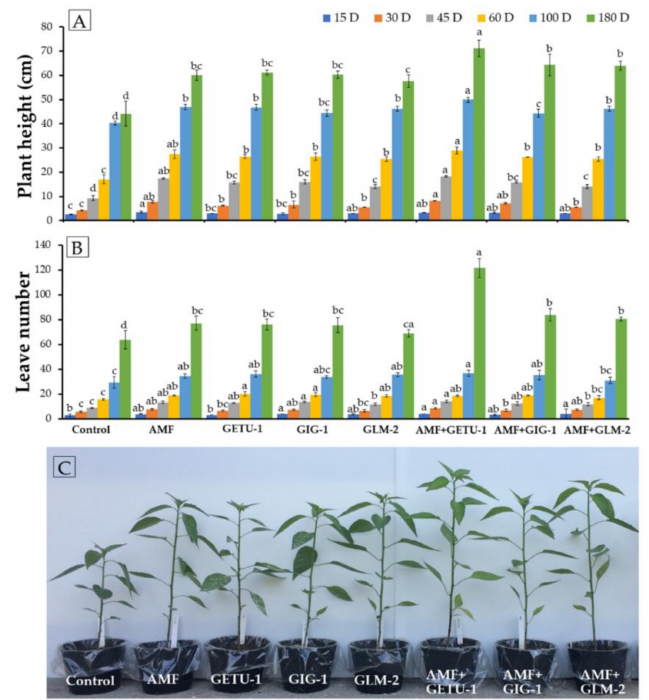
Figure 4. The height ( A ) and leaf number ( B ) of chili plants in each experiment during 15–180 days of planting under the greenhouse condition. The height of chili plant after 30 days of planting ( C ). The means with the standard deviation bar are shown in each graph. Different letters above each graph in the same experiment indicate that the means are significantly different by DMRT ( p <